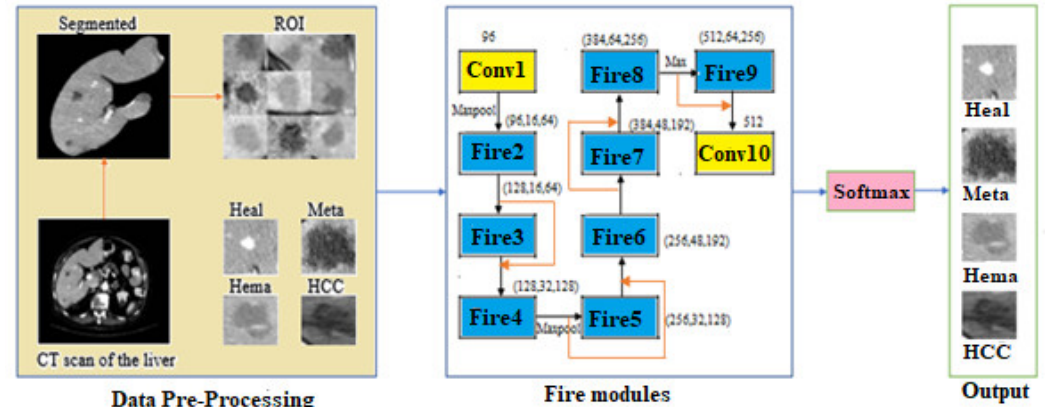
Figure 1. Overall structure of our proposed FireNet method for liver lesions classification.